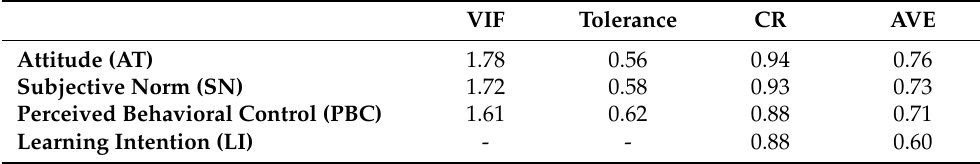
Table 5. Multicollinearity and discriminant validity.